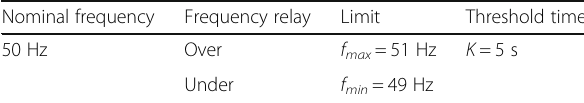
Table 3 Frequency relay